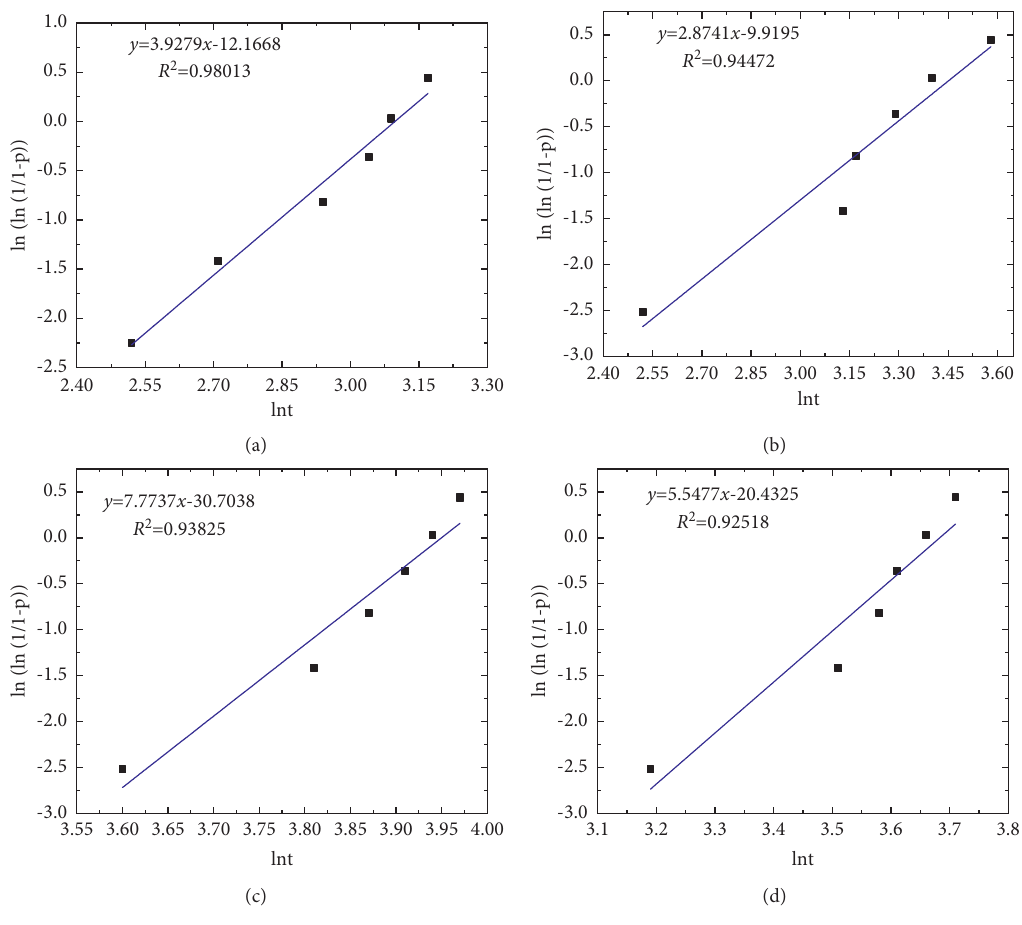
Figure 15: ln(ln(1/1 − p ( t ))) curves under different stress levels: (a) σ -0.5, (b) σ -0.6, (c) σ -0.7, and (d) σ -0.8. Table 4: Characteristic parameters of Weibull